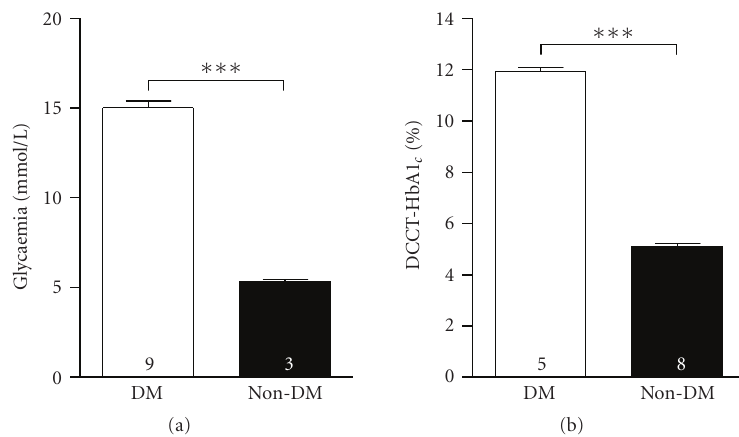
Figure 2: Blood glucose and HbA 1c levels are increased in long-term diabetic (DM) BBDP rats. (a) Average blood glucose level during the entire follow-up period starting at diabetes onset until sacrifice (ranging from 150 to > 200 days) (white bar). For comparison, mean blood glucose levels in age-matched non-DM BBDP rats are shown (black bar). (b) Hyperglycaemia in long-term diabetic BBDP rats is associated with increased glycated haemoglobin (HbA 1c ) levels (white bar) compared with non-DM rats (black bar). Data are expressed as the mean ± SEM ( ∗∗∗ P < . 001). Values within bars indicate the number of rats analyzed. DM: long-term diabetic BBDP rats, Non-DM: non-diabetic rats.